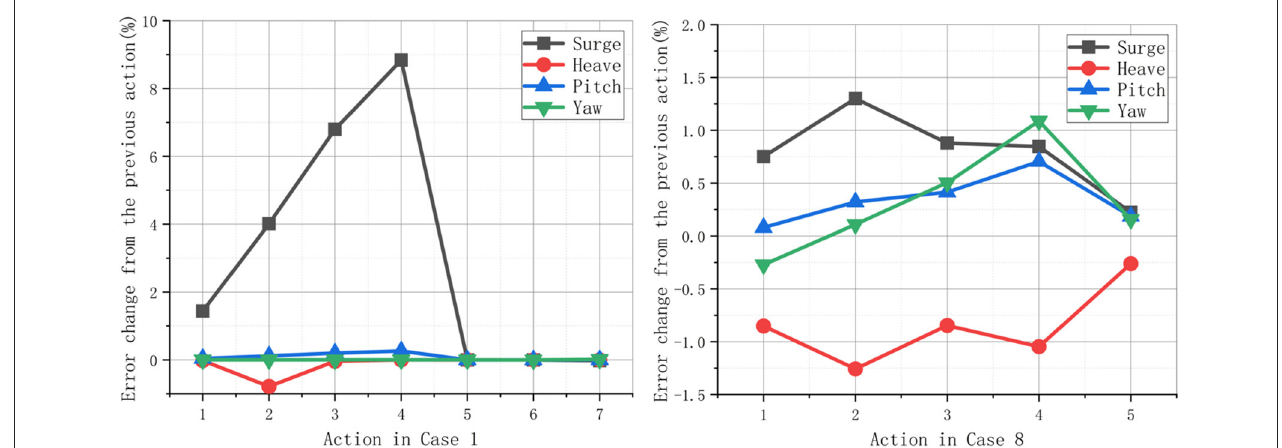
FIGURE 4 | Comparison in each action under case 1 & 8.